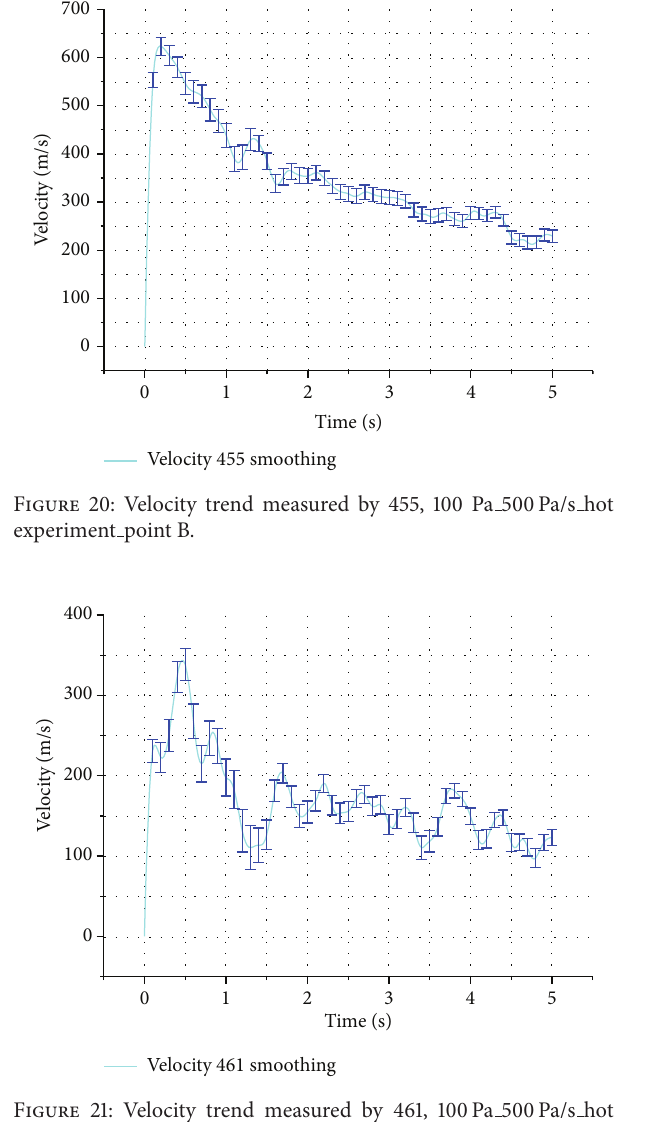
Figure 23: Comparison between hot and cold experiments at 100Pa 100 Pa/s for the lateral